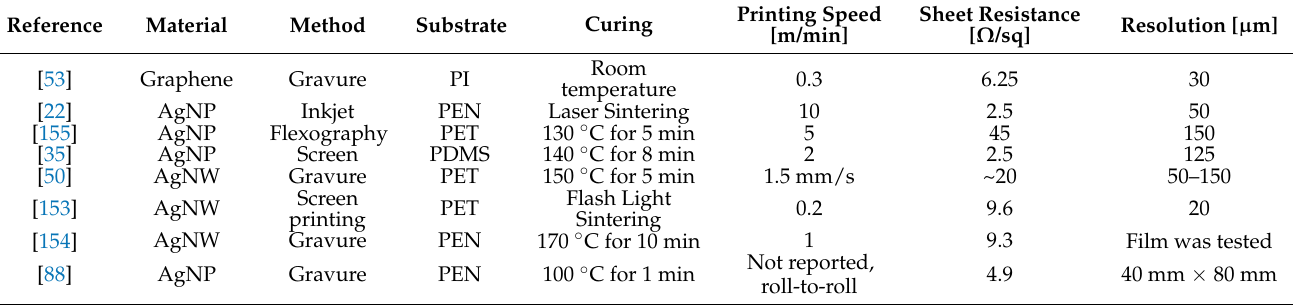
Table 2. High-throughput nanomaterial interconnection